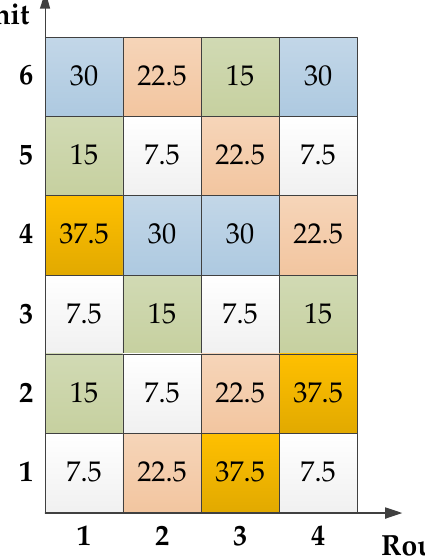
Figure 3. Prescription value setting in each operation unit.